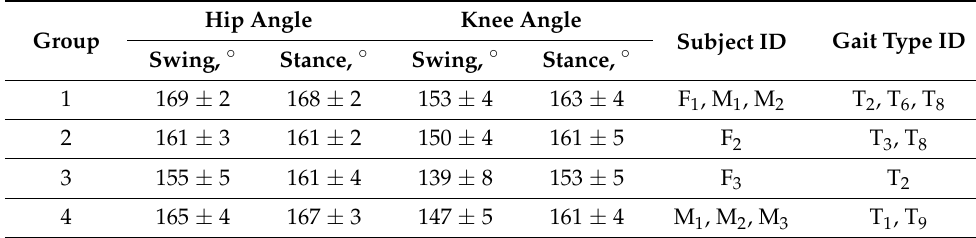
Table 1. Cluster groups